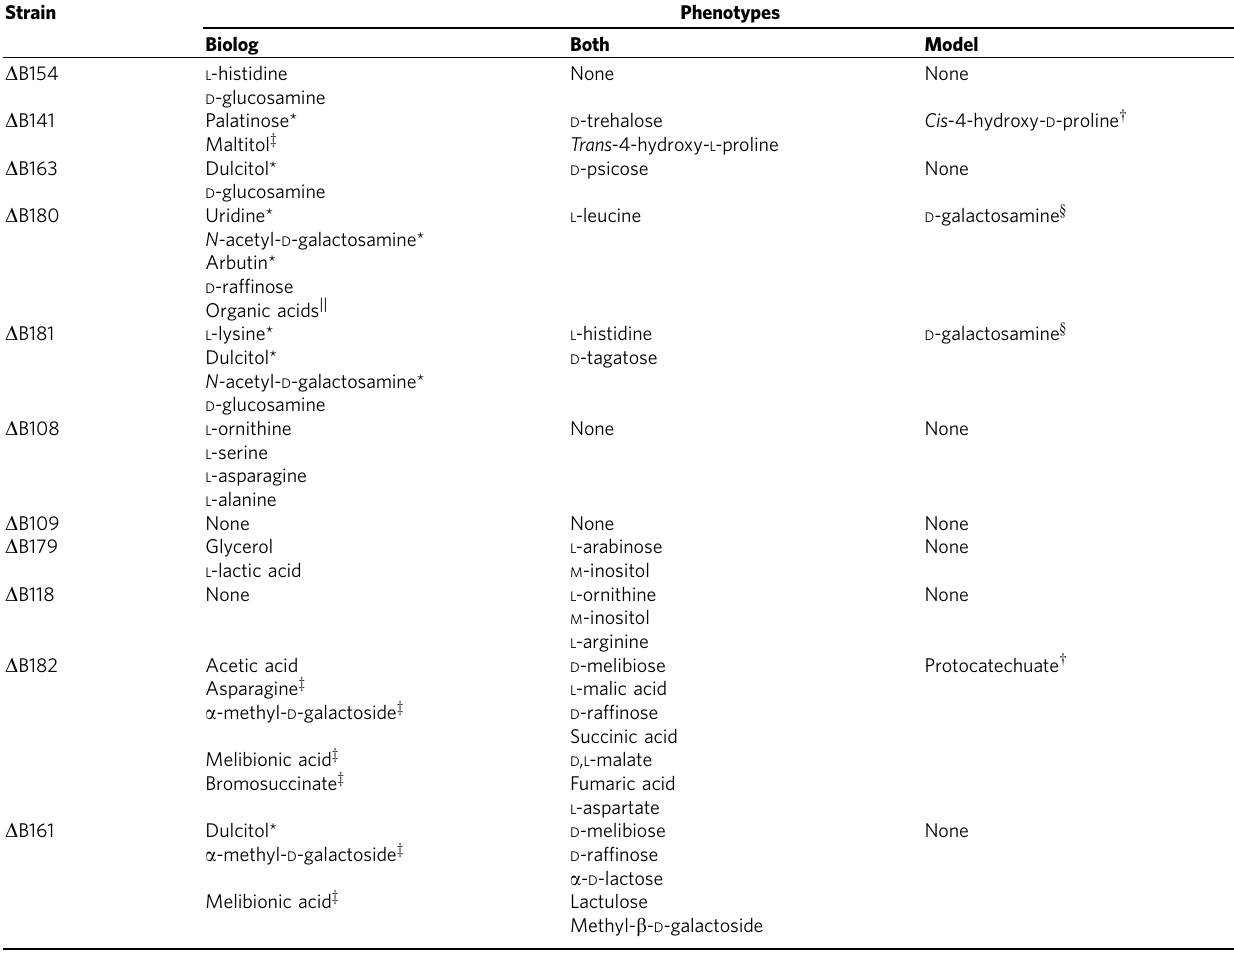
Table 2 | Carbon utilization phenotypes observed for pSymB deletion mutants.